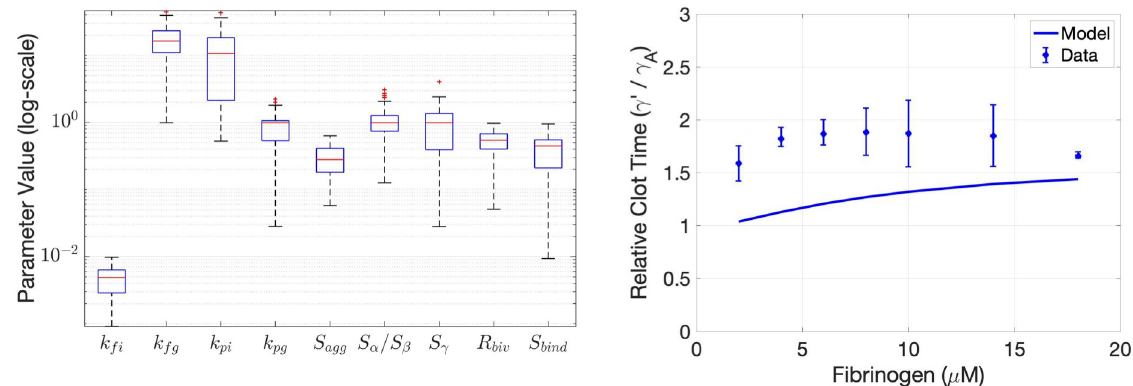
Fig 6. Protofibril number and structural quantities after long periods of time: Comparing model output with experiments. Shown are the experimentally measured fiber radii [32] in (A). Model outputs as a function of both the thrombin concentration and γ 0 :E-domain ratio: (B) protofibril number, (C) protein density and (D) distance between protofibrils. The quantities in C,D are computed by combining the measurements in A with a post-processing of the model output in B.